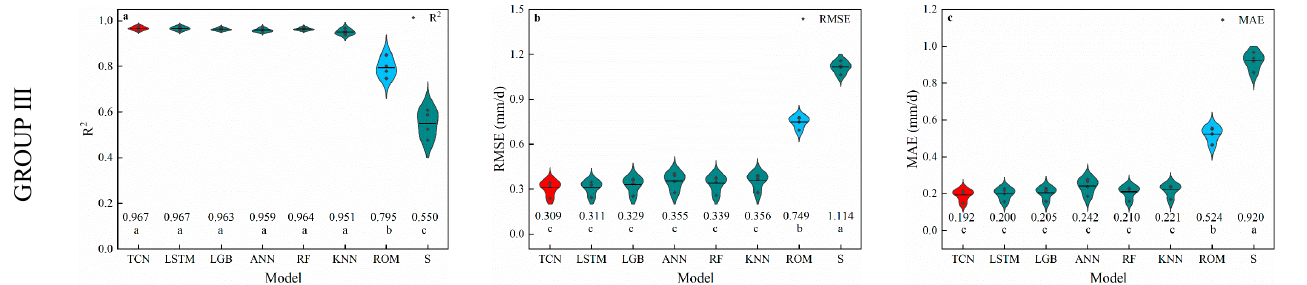
Figure 7. The performance of the humidity-based models during the first strategy: ( a ) determination coefficient (R 2 ), ( b ) root mean square error (RMSE), and ( c ) mean absolute error (MAE).